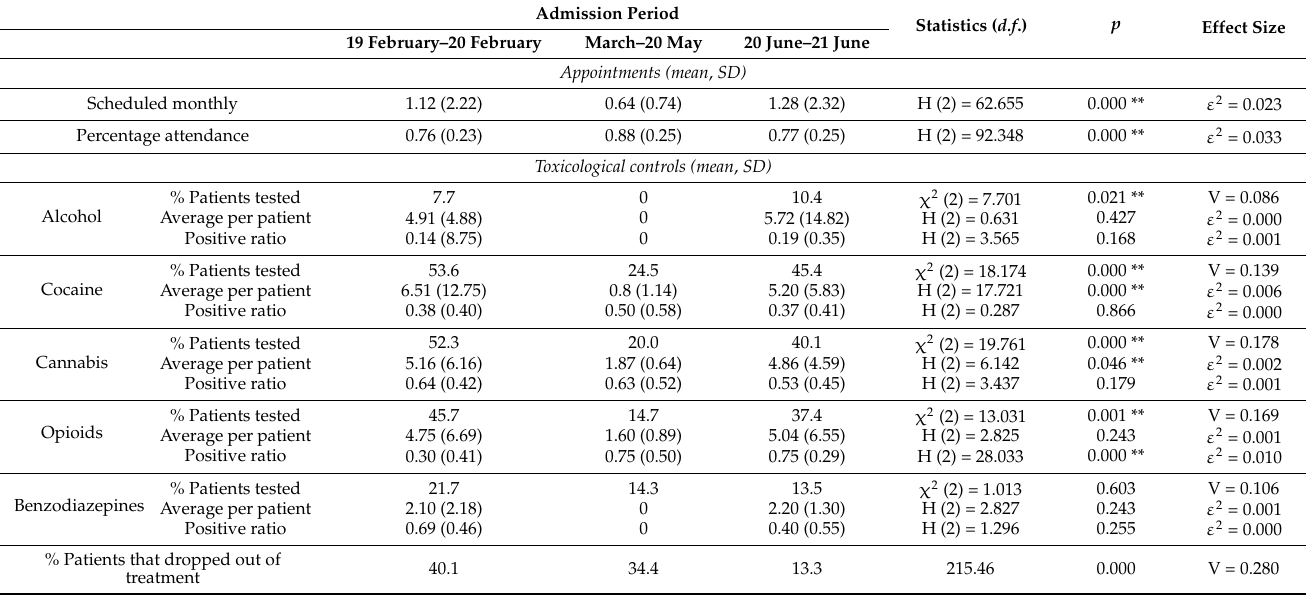
Table 2. Care indicators for patients with dual